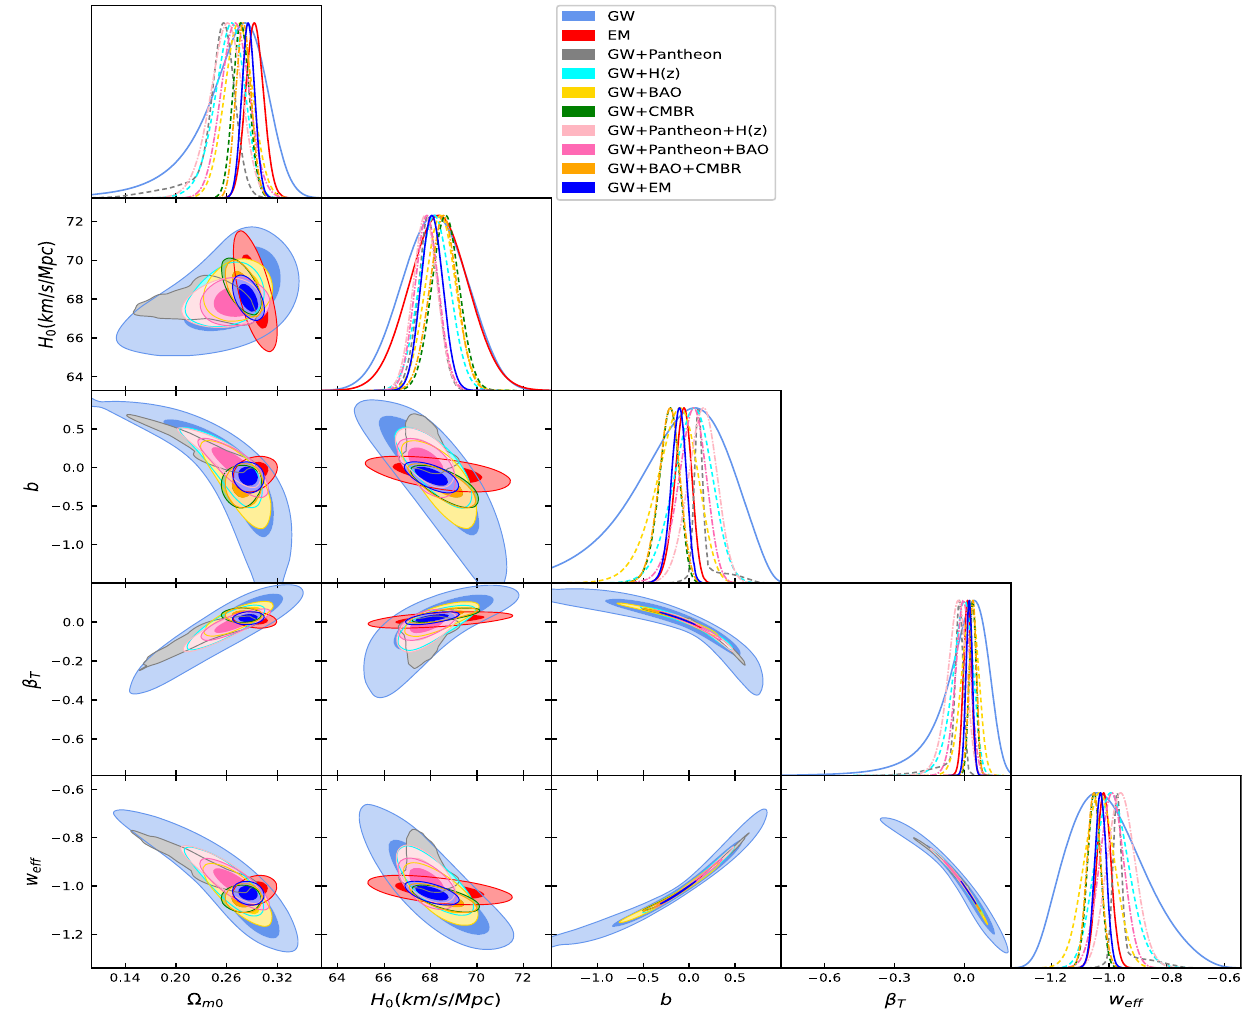
Fig. 2 The probability density functions (pdfs), the 68% (1 σ ) and 95% (2 σ ) confidence regions for the parameters ( (cid:4) m 0 , H 0 , b , β T and w e f f ) in the f p CDM model